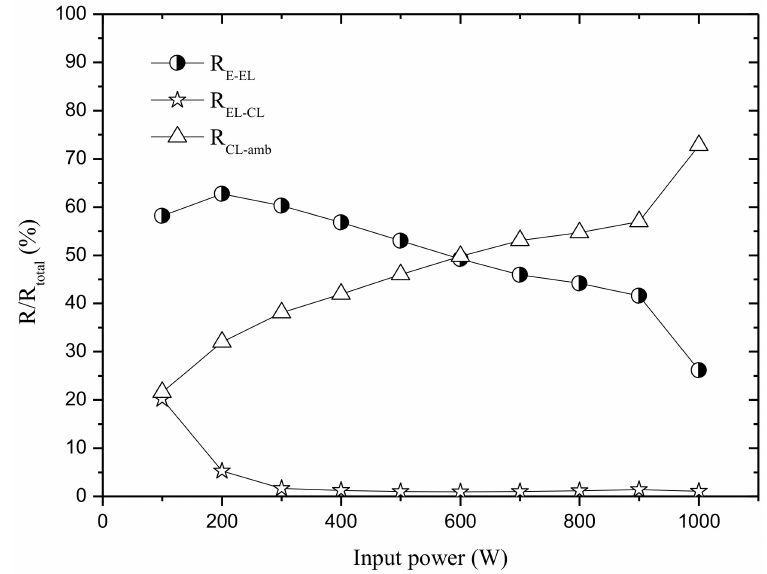
Figure 10. Thermal resistance ratio vs. input power of the PHP thermal